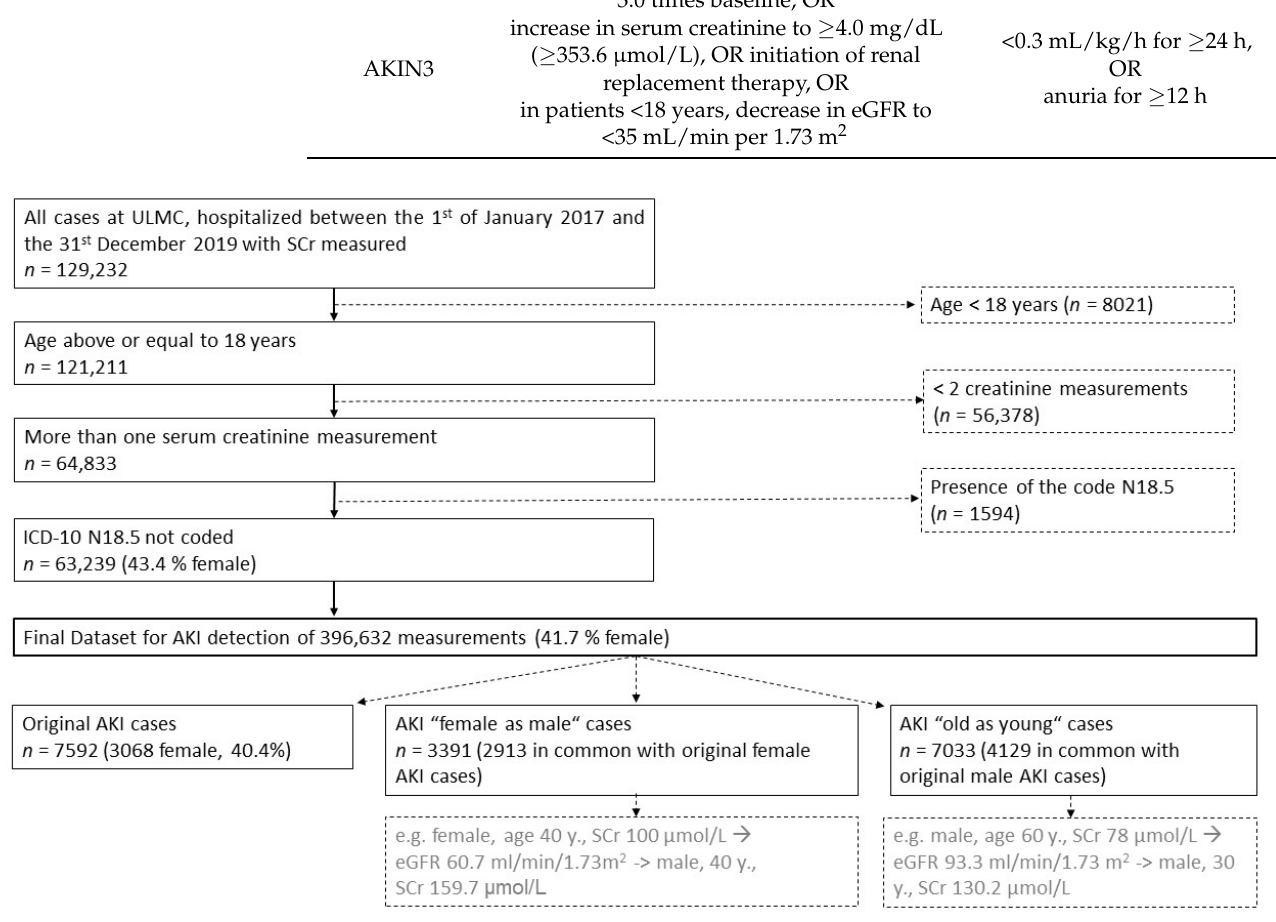
Figure 1. Study cohort with inclusion and exclusion criteria. n —number of